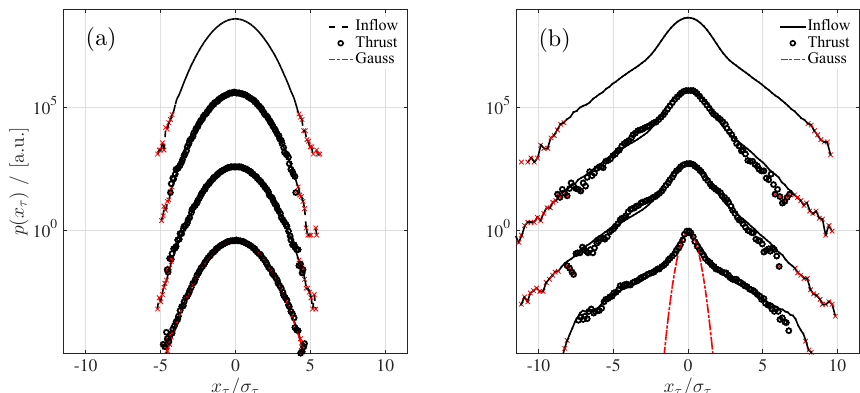
Figure 9. p ( u τ ) (lines) and p ( F τ ) (circles) for both Gaussian (a) and intermittent (b) inflow conditions. Scales as in Fig. 8 from top to bottom, τ = { 25 , 67 , 80 ms , 2 s } , shifted vertically for presentation.